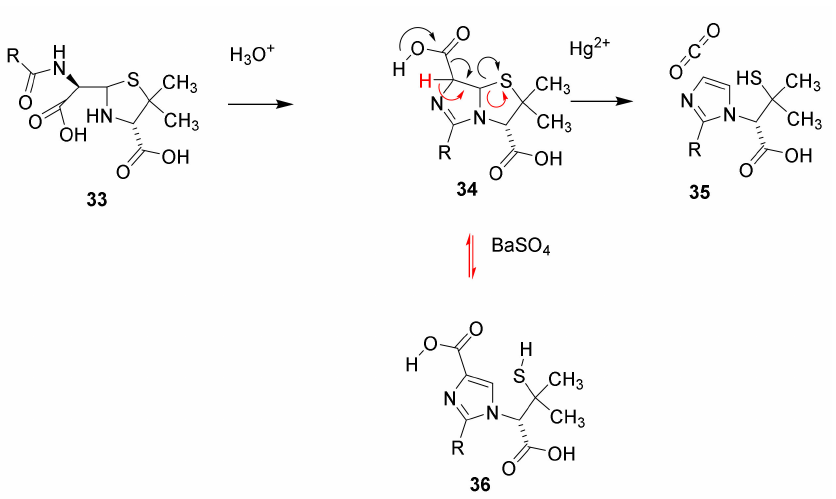
penillo-aldehyde ( 29 ). Treatment with benzylamine yields aminolysis of the β -lactam to give the benzylammonium salt of the benzylamide 30 . Methanolysis affords the monomethyl ester of